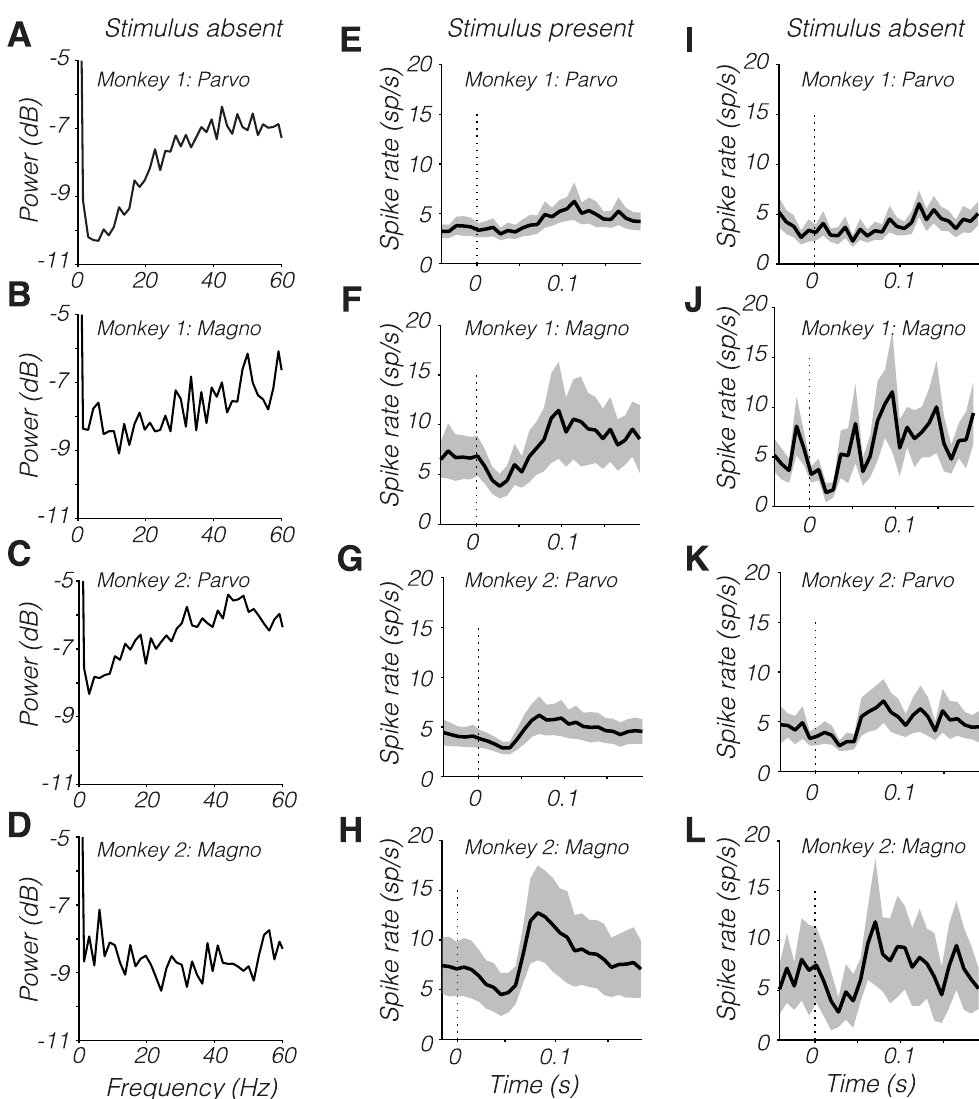
Fig 6. (A–D) Power spectra of spike trains on stimulus-absent trials. (E–L) Microsaccade-triggered spike time histograms from stimulus-present trials (E–H) and stimulus-absent trials (I–L). Dark traces are means and shaded bands are ± 1 standard error. Data are available at https://github.com/horwitzlab/LGN-temporal-contrast-sensitivity/blob/master/ DataByFigure.xlsx. Magno, magnocellular; Parvo,